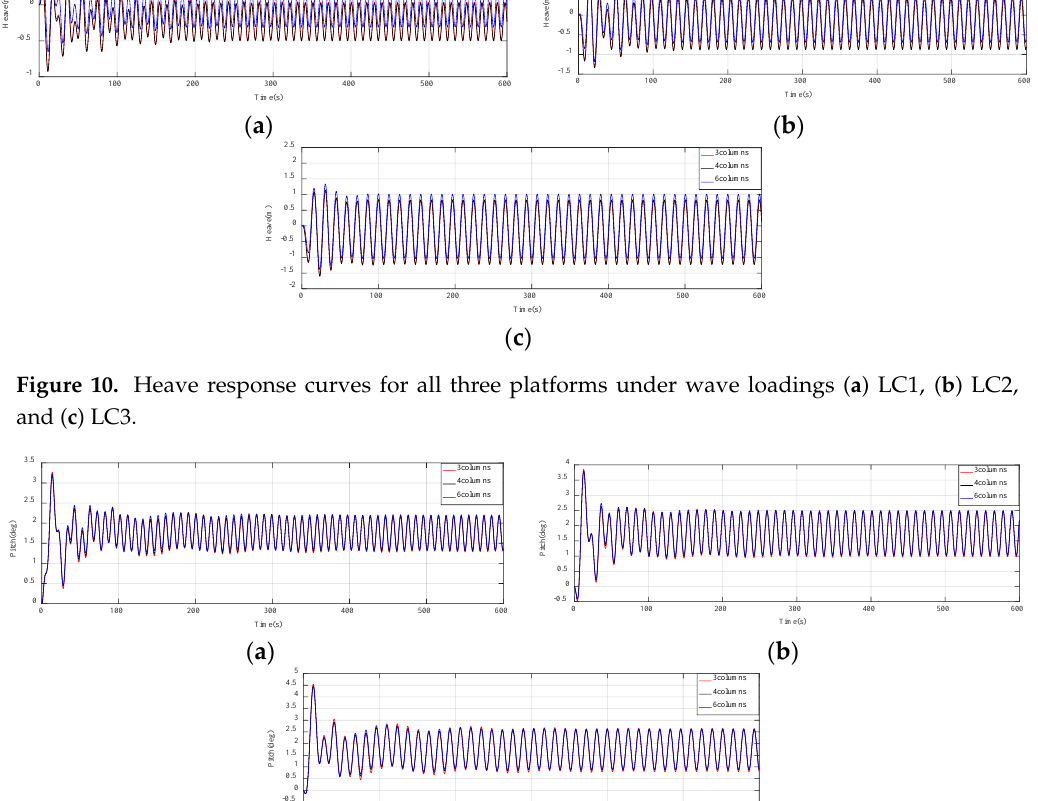
Figure 10. Heave response curves for all three platforms under wave loadings ( a ) LC1, ( b ) LC2, and ( c ) LC3.